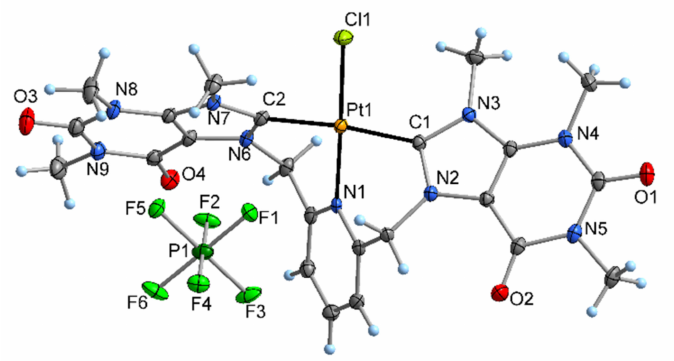
Figure 2. Molecular structure of 7 in the crystalline solvate 7 · CH 3 CN, showing the atom numbering scheme. Ellipsoids are drawn at the probability level of 50% and hydrogen atoms as spheres of arbitrary size; the CH 3 CN of crystallization was omitted for clarity. Selected bond lengths [Å] and angles [ ◦ ]: Pt1-Cl1, 2.2976(6); Pt1-N1. 2.057(2); Pt1-C1, 2.024(2); Pt1-C2, 2.014(2): N1-Pt1-Cl1, 178.50(5): C1-Pt1-Cl1, 93.38(6); C1-Pt1-N1, 87.80(7); C2-Pt1-Cl1, 92.99(6); C2-Pt1-N1, 85.82(7); C2-Pt1- C1,